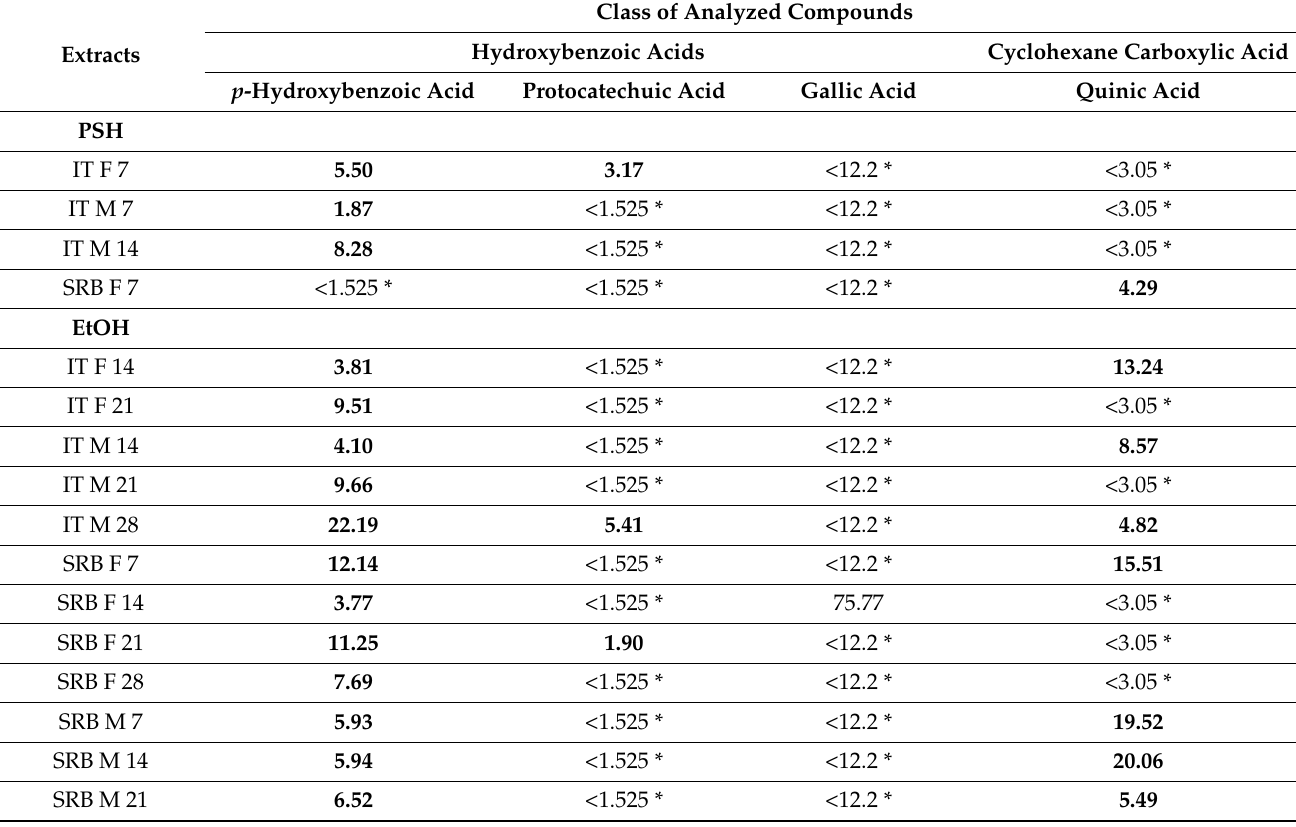
Table 3. Determined concentrations of selected phenolic compounds using LC–MS/MS technique in examined polysaccha- ride and ethanolic extracts ( µ